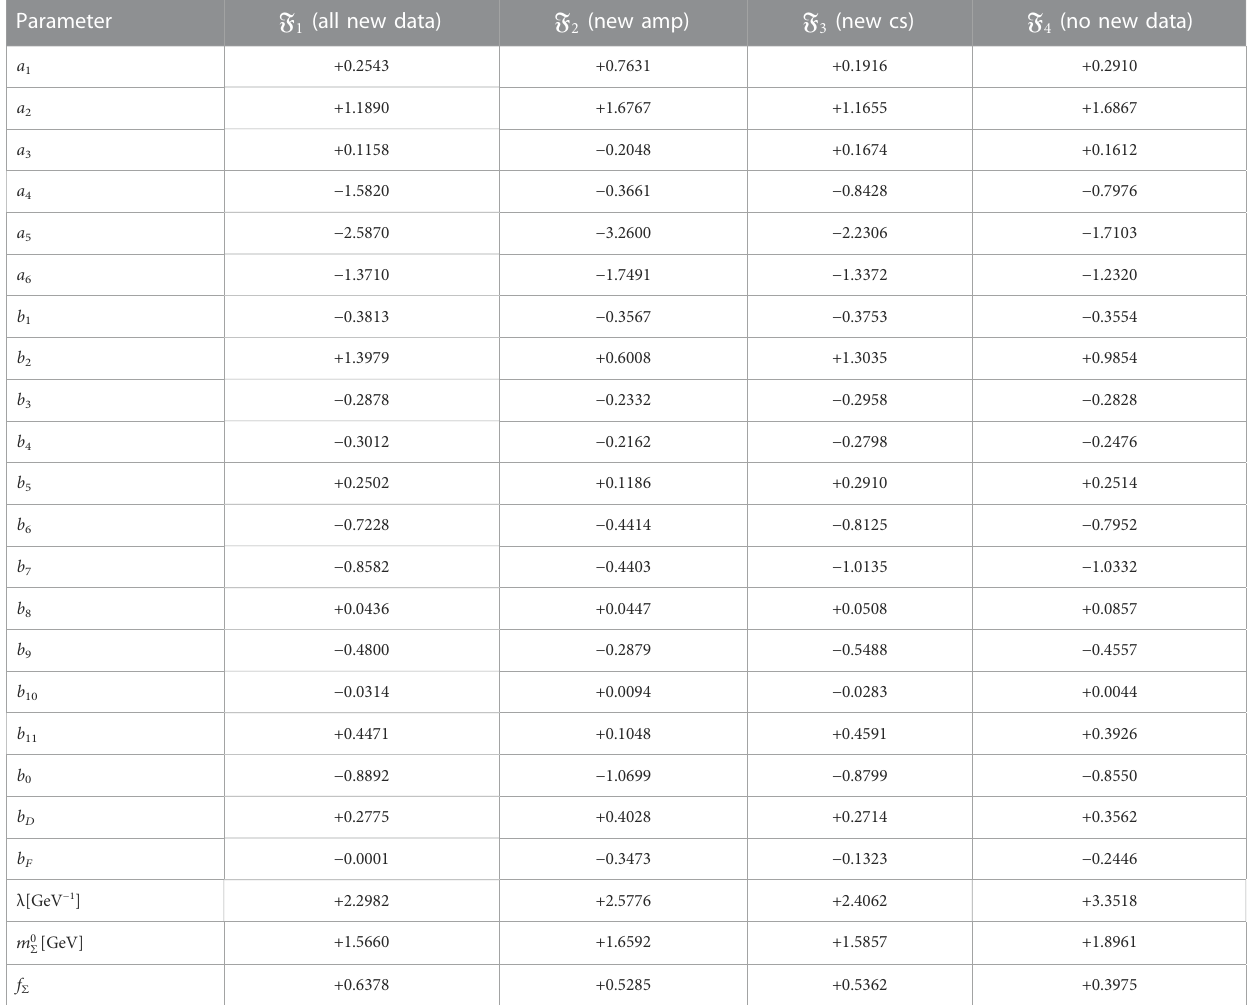
TABLE A1 Best fi t parameters for the four fi t scenarios. These parameters are accessible in digital form in auxiliary arXiv- fi les.